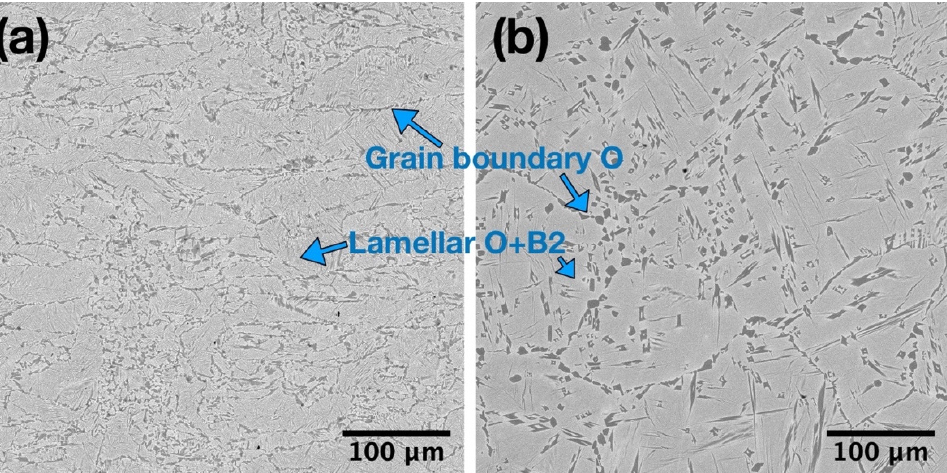
Figure 11. Microstructure of the samples produced from ( a ) the Ti 2 AlNb-CYB and ( b ) the Ti 2 AlNb- noCYB powders after HIP.